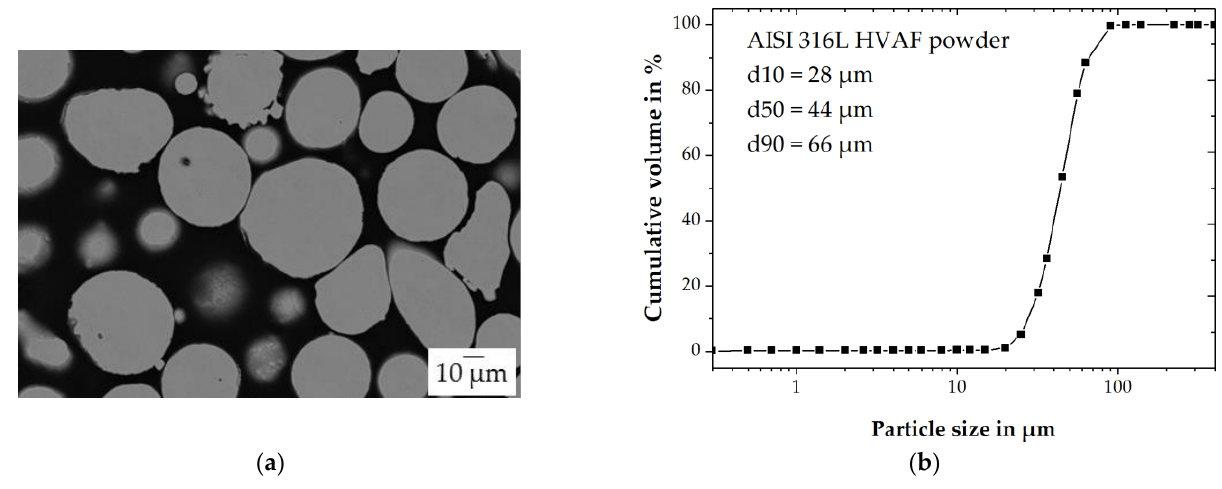
Figure 2. Characterization of the AISI 316L powder: ( a ) BSD-SEM image and ( b ) particle size distribution measured with laser particle size analyzer CILAS.